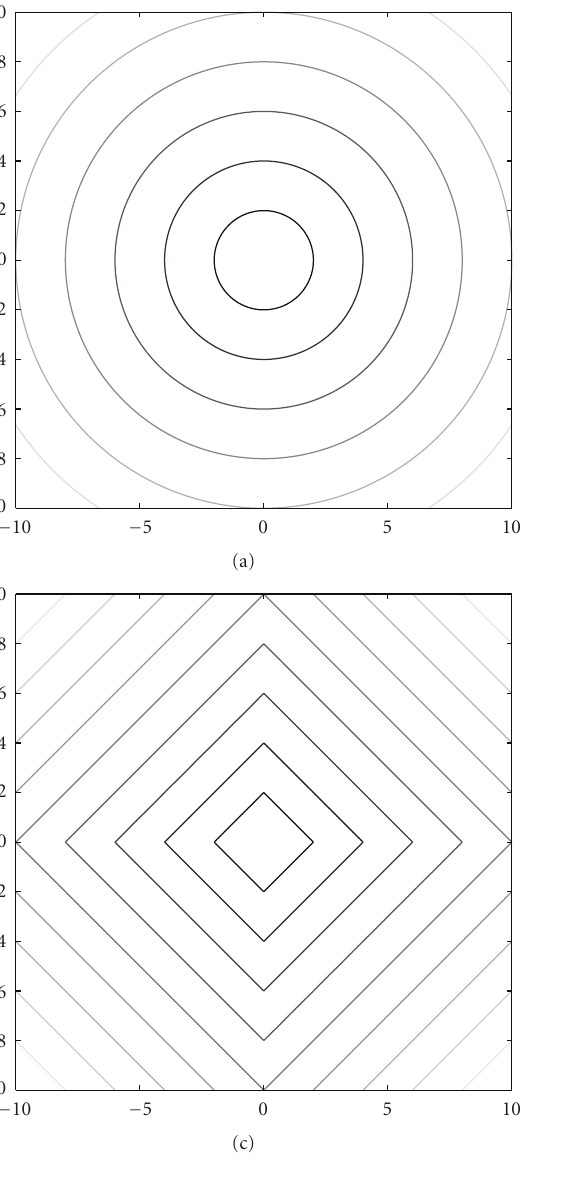
Figure 4: Contour plots of di ff erent metrics for two dimensions: (a) L 2 , (b) LL 2 (Lorentzian), (c) L 1 , and (d) LL 1